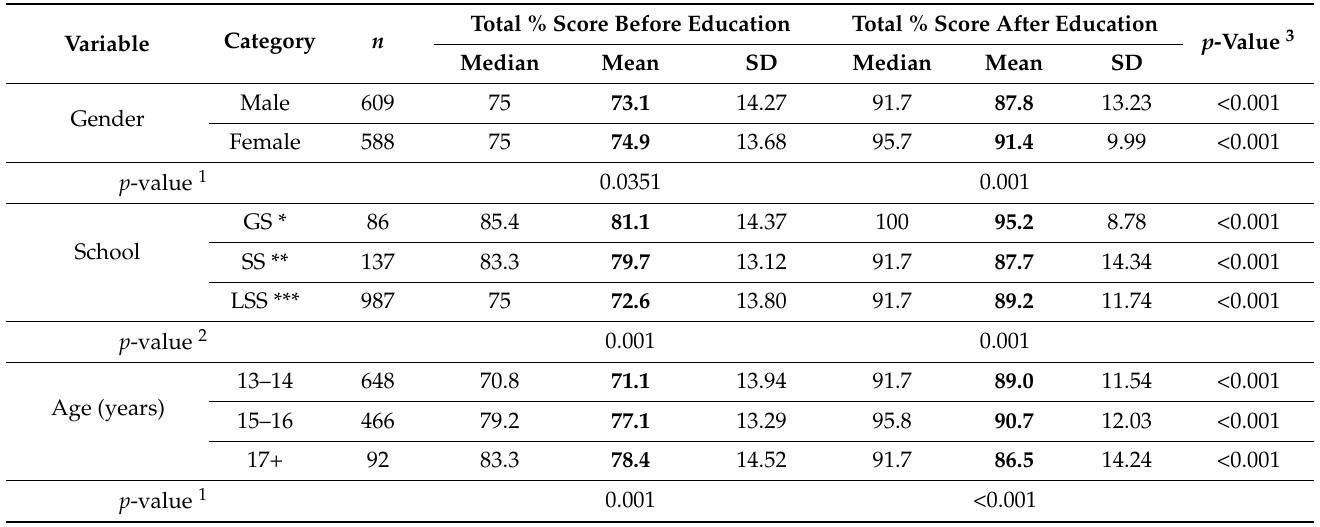
Table 4. Average values of total scores (%) before and after education by sex, age, and type of school.